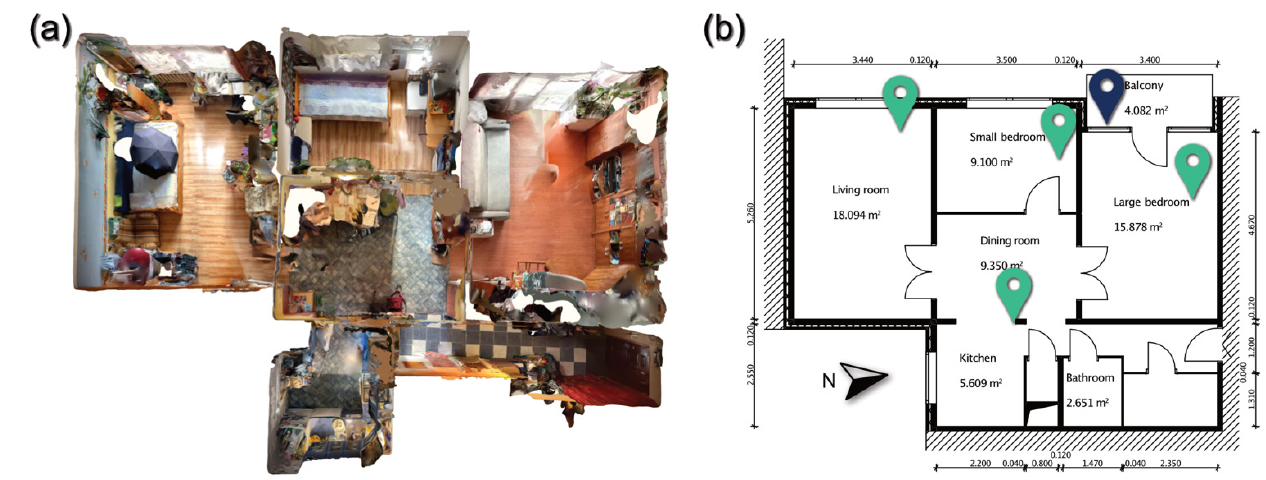
Figure 2. ( a ) LiDAR survey; ( b ) floor plan and layout of the studied dwelling with the indicated position of the room